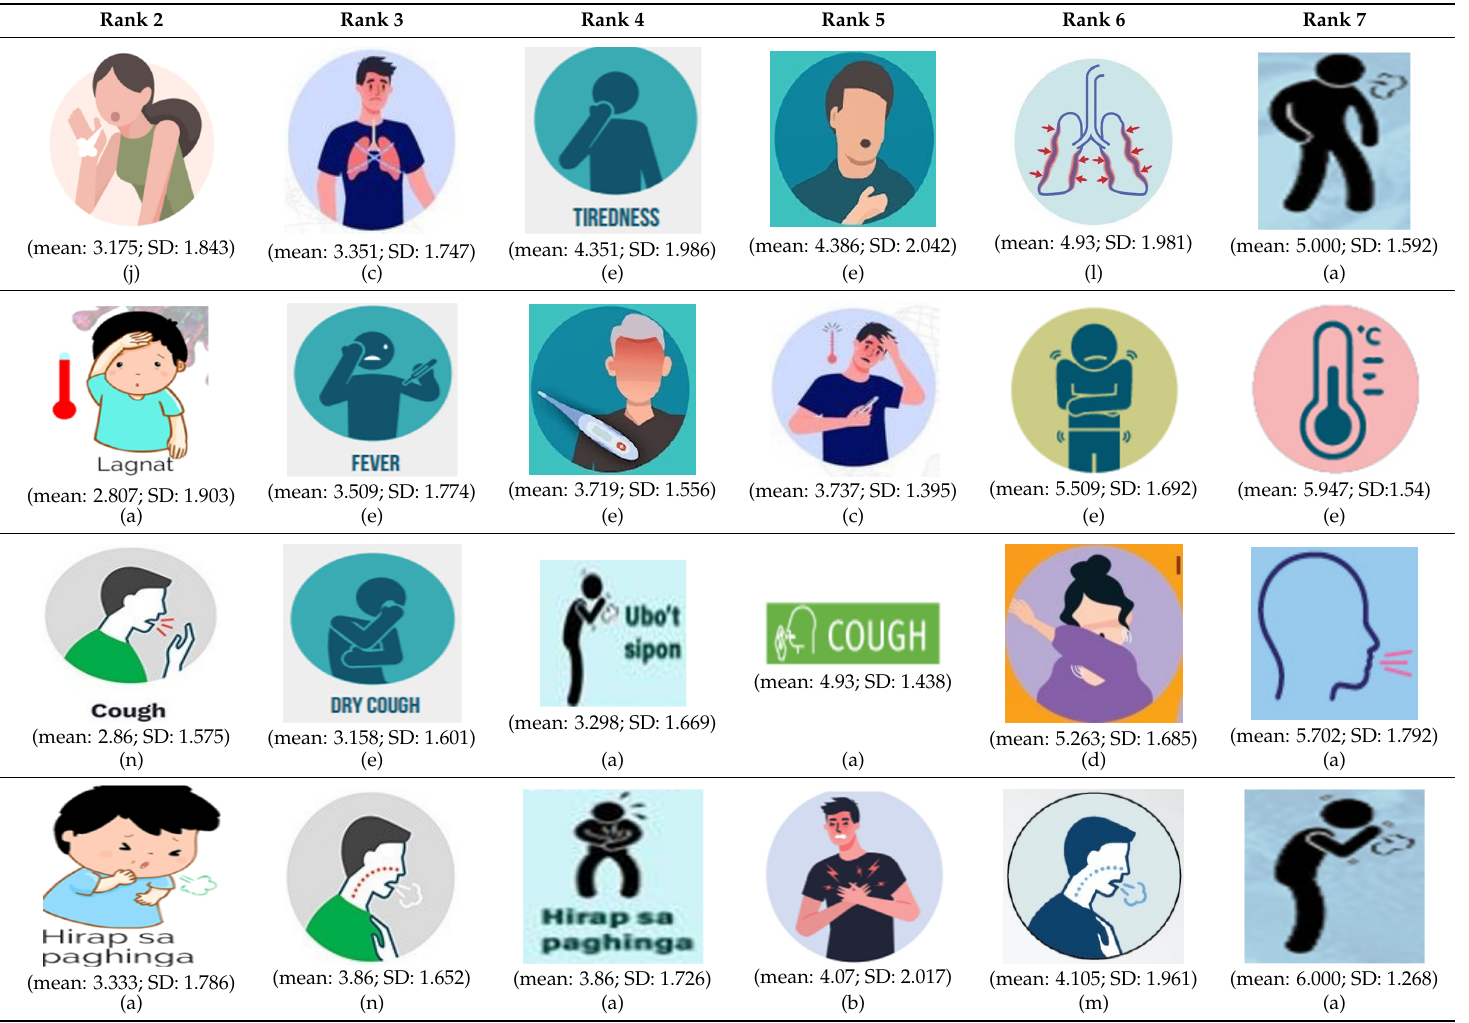
Table 3. Icons tested in the current study and their summarized results from the preference test.